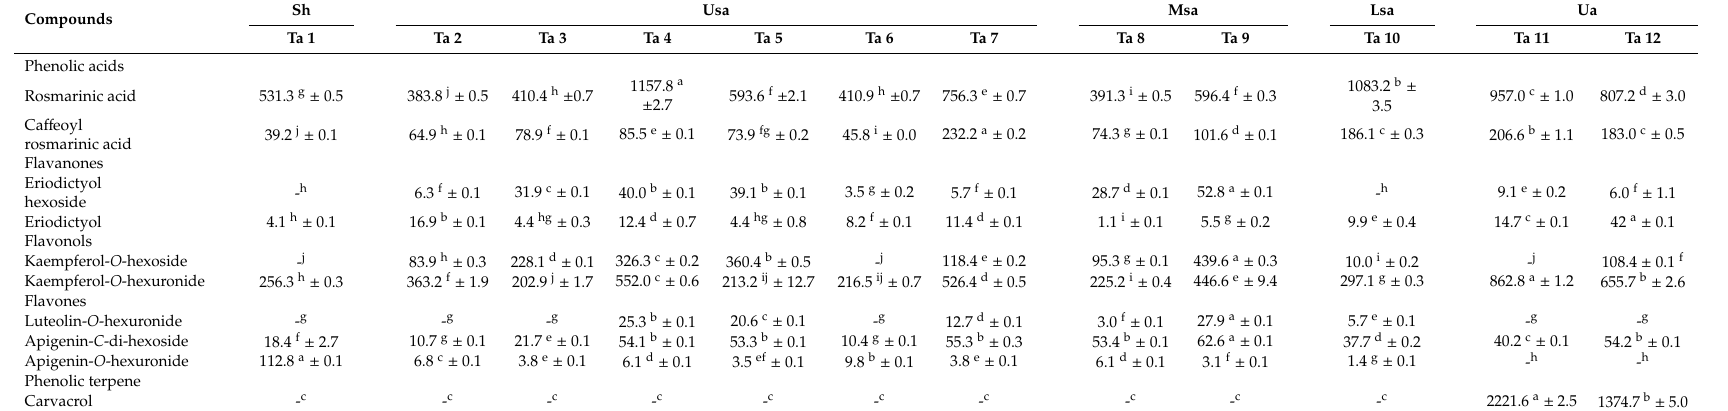
Ta 1–12 correspond to the code number as detailed in Table 1. Sh, Usa, Msa, Lsa, and Ua: sub humid, upper semi-arid, mean semi-arid, lower semi-arid, and upper arid bioclimatic zones, respectively (See Table 1). Numbers in lines followed by the same letter are not significant at p > 0.05 (Duncan’s multiple range